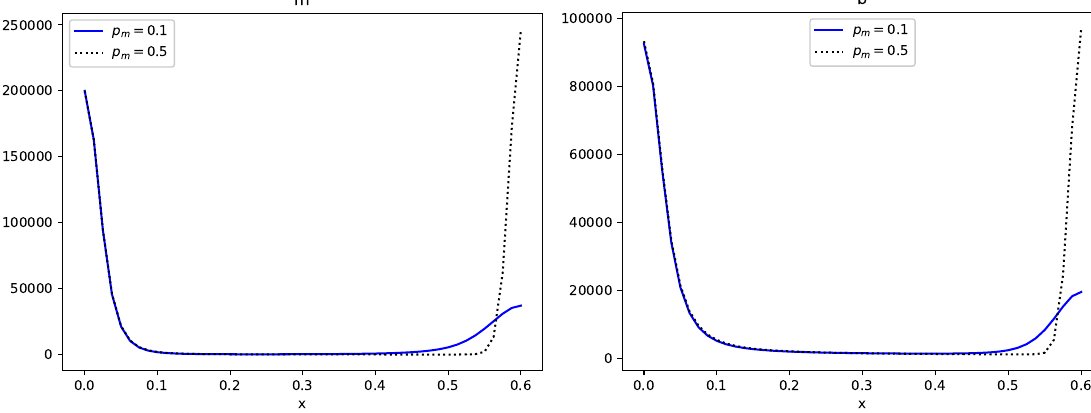
Figure 6. Concentration of osteogenic cells (left) and osteoblasts (right) at the final time for the case of p m = 0.1 (blue) and p m = 0.5